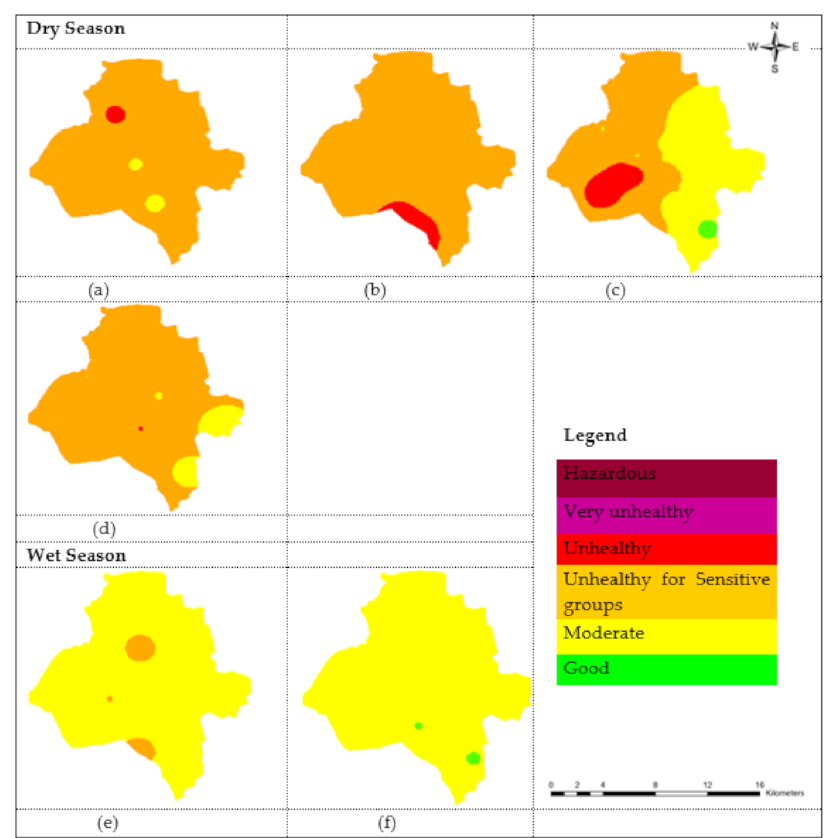
Figure 7. Estimated PM 2.5 concentrations as per the Air Quality Index (AQI) for each of the im- age dates used in this study: ( a ) 9 February 2020 (OLI), ( b ) 9 February 2020, ( c ) 29 January 2021, ( d ) 28 February 2021, ( e ) 21 September 2020 and ( f ) 25 March